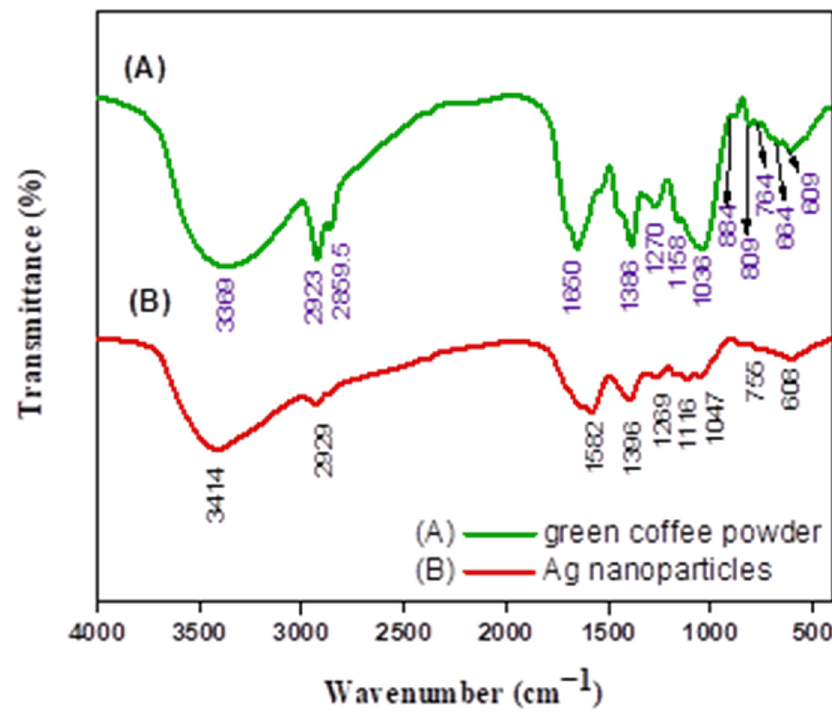
Figure 3. FTIR spectra of green coffee powder ( A ) and GC-capped Ag NPs ( B ).